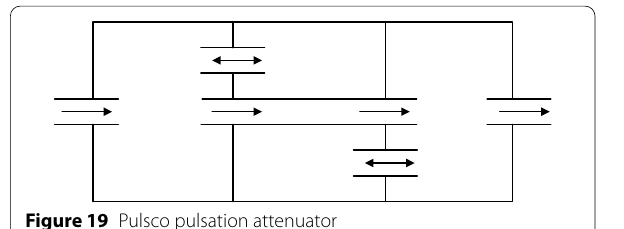
Figure 19 Pulsco pulsation attenuator